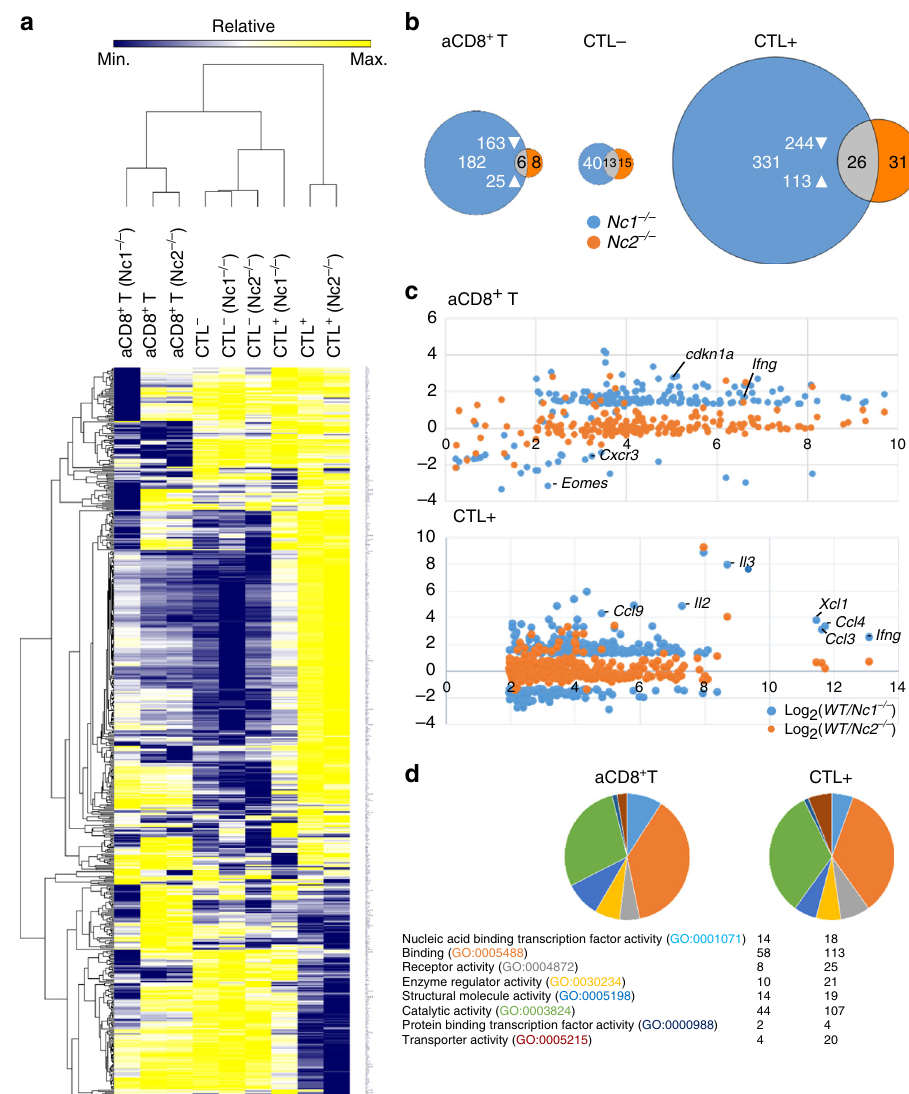
Fig. 4 Transcriptome assays of CD8 + T cells by next generation sequencing. a Heat map of 561 genes whose expression changed twofold in either Nfatc1 − / − ( Nfatc1 f/f x CD4-cre mice) or Nfatc2 − / − aCD8 + Ts and CTLs. b Number of genes whose expression was changed 2.5-fold in either aCD8 + Ts, CTL − or CTL + cells. Genes whose expression was speci fi cally changed in Nfatc1 − / − cells are shown in blue , those changed in Nfatc2 − / − cells in orange, and those changed in both in gray . c Scatterplots of NFATc1- and NFATc2-dependent genes relative to Log 2 WT expression in aCD8 + Ts ( upper panel ) and CTL + cells ( lower panel ). d Functional annotation of genes changed 2.5-fold in RNA levels in NFATc1-de fi cient aCD8 + Ts and CTL + cells according to the PANTHER pathway analysis